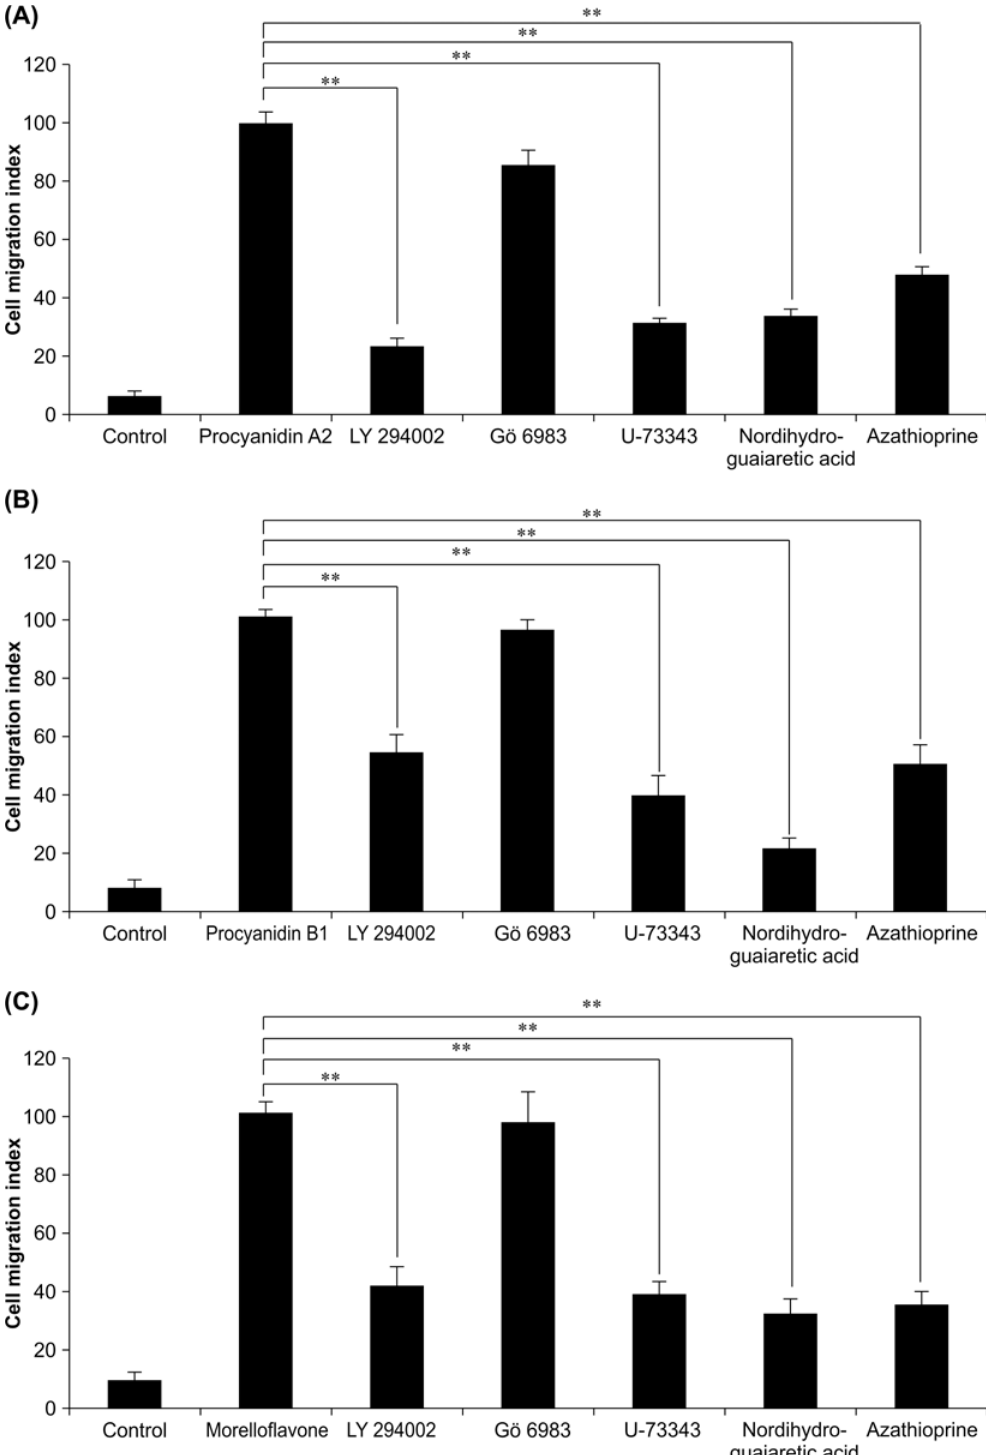
Fig 5. Effects of specific inhibitors on biflavonoid-induced migration of KUM6 cells. (A) Procyanidin A2, (B) procyanidin B1, and (C) morelloflavone. Inhibitors were used at 25 μ M, 50 nM, 1 μ M, 25 μ M, and 100 μ M for LY294002, Gö6983, U-73343, nordihydroguaiaretic acid, and azathioprine, respectively. Values are mean ± SE of migration indices normalized to that of biflavonoid-treated cells; n = 4/group, ** P < 0.01 vs. control.